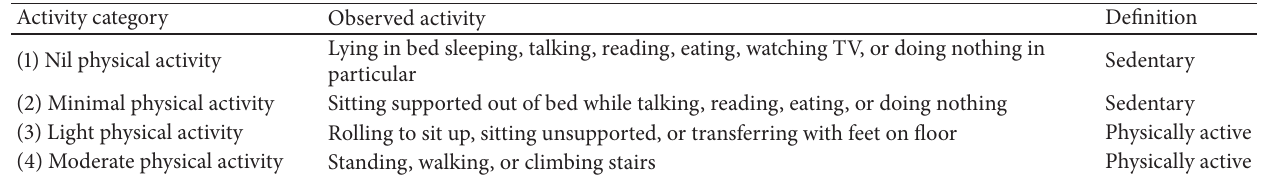
Table 1: Categorization of